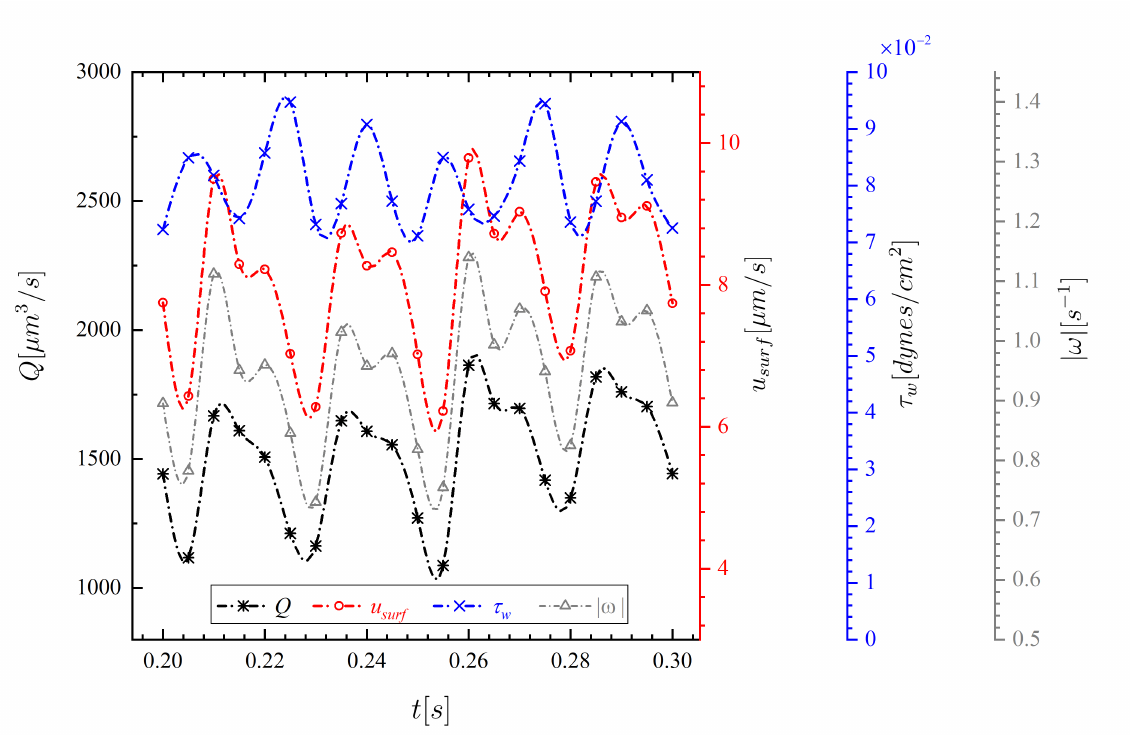
Figure 7. Transients of PCL flow rate Q , surface mean velocity u surf , wall shear stress τ , and volume-averaged vorticity magnitude | ω | for the standard case over the third